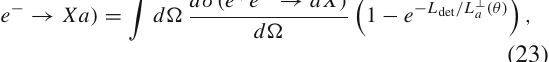
Fig. 2 Production cross sections of ALPs produced in the decays of Higgs and Z bosons at the LHC √ s = 14TeV) versus the ( new-physics scale (cid:2) . We set m a = 0 and fix the relevant Wilson coefficients to 1. For the green contour in the left plot, we ( 5 ) = 0 and only consider fix C Zh the dimension-7 coupling in (5). The grey regions in the two plots are excluded by Higgs coupling measurements and the measurement of the total Z width, respectively